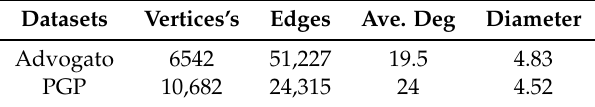
Table 4. Statistics of the Advogato and PGP datasets.